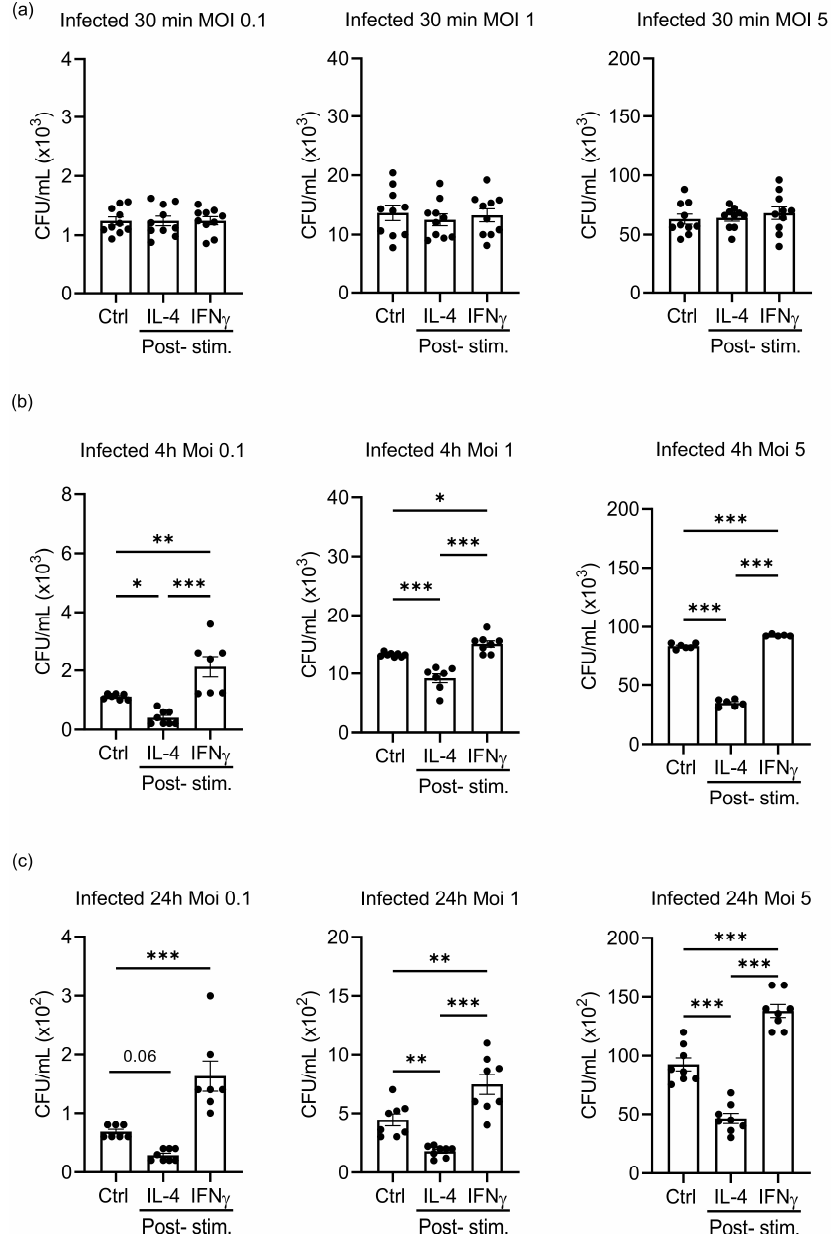
Figure 6. Different multiplicities of infection do not alter the effects of IL-4 and IFN γ stimulation on the growth of S .tm in macrophages. Unpolarised BMDM were infected with S .tm for 1 h. Afterwards, cells were stimulated (post-stimulation) with 10 ng/mL IL-4, 100 ng/mL IFN γ or left unstimulated as indicated. ( a ) CFU analysis after 0.5 h ( a ), 4 h ( b ) and 24 h ( c ) of infection with several multiplicities of infection (MOI) of S .tm in post-stimulated BMDM. Statistical significance was determined by one-way ANOVA with Tukey post hoc test: * p -value < 0.05; ** p -value < 0.01; *** p -value < 0.001. Representative data (mean ± SEM) from three independent experiments with 2–3 technical replications are shown.